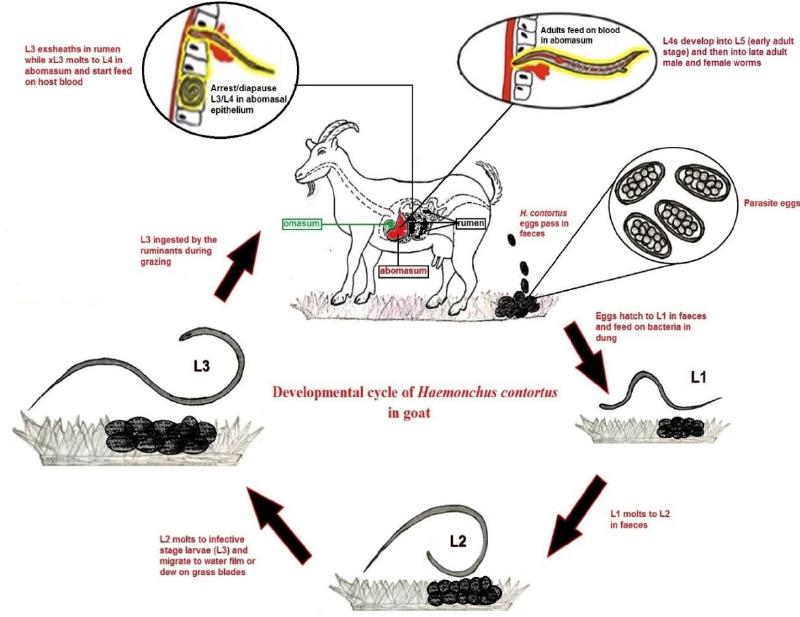
Figure 1. Developmental life cycle of Haemonchus contortus parasite in goat.